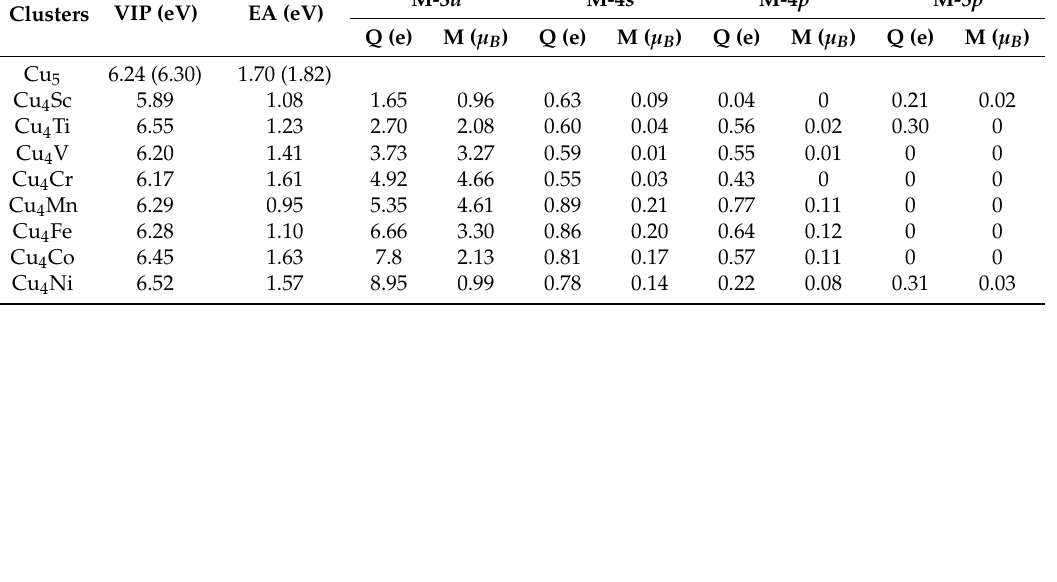
Figure 7. Simulated PES of the ground state Cu 4 M (M = Sc-Cu) clusters.